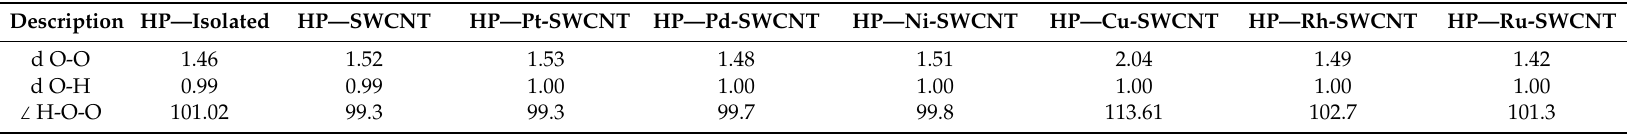
Table 1. Bond distances (d) and angles ( ∠ ) of the H 2 O 2 (HP) molecule before and after interaction with pristine and metal decorated